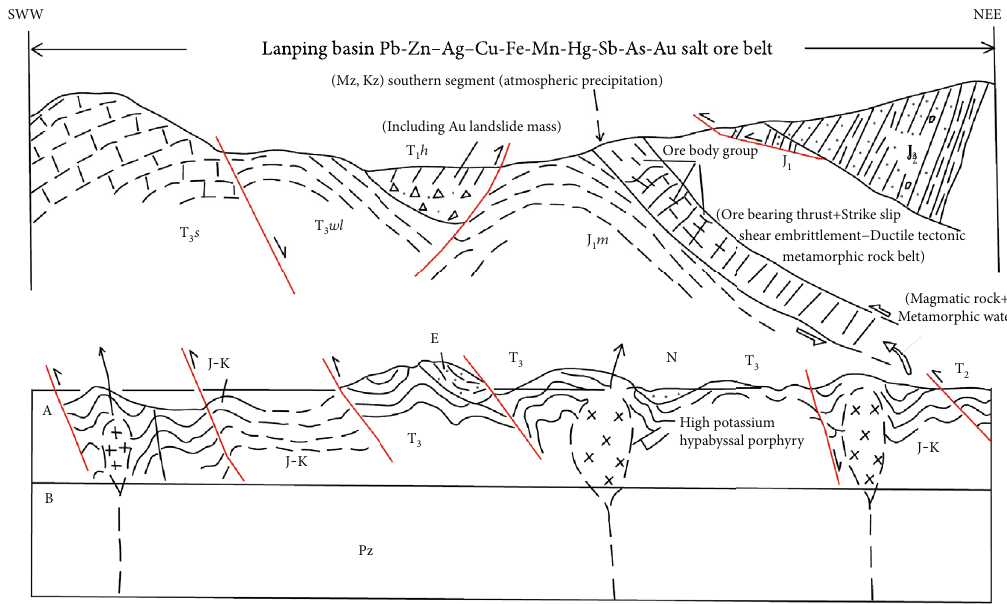
Figure 5: Zhacun goldmine metallogenic system